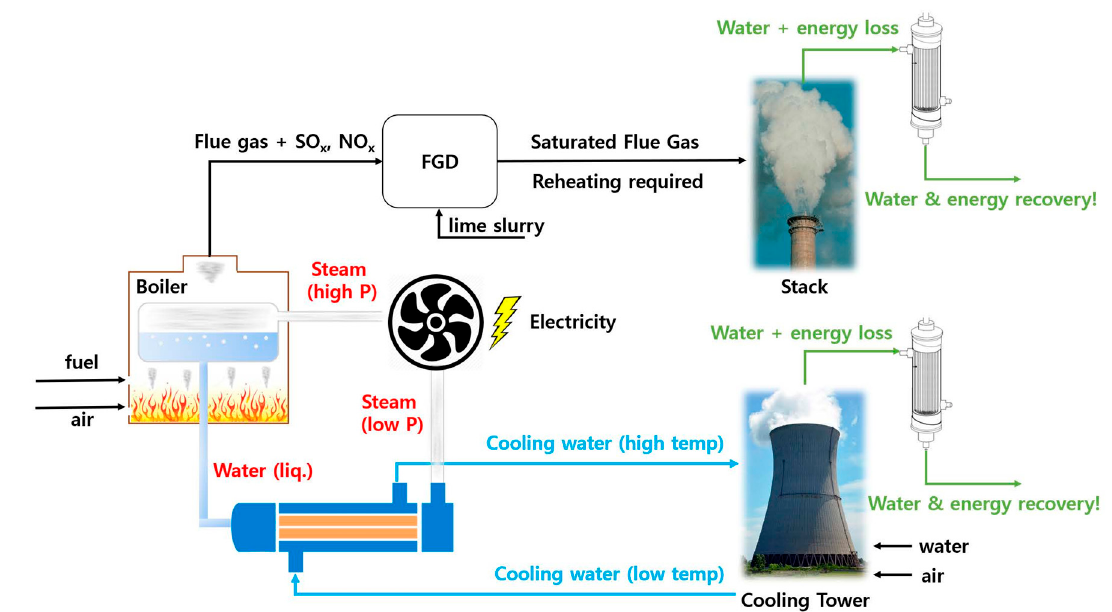
Figure 2. Schematized diagram of power plant operation and sources of water vapor loss. (Reprinted with permission from [6].)